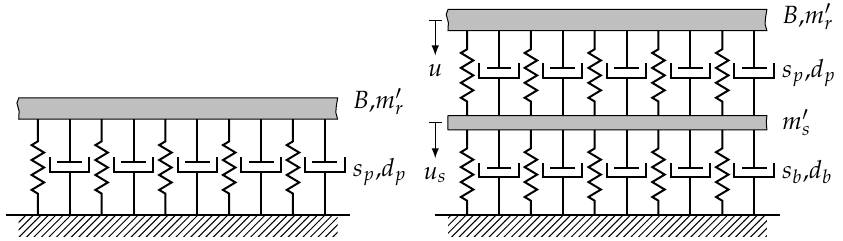
Figure 2. Models for single-layer and two-layer elastic foundations with continuous